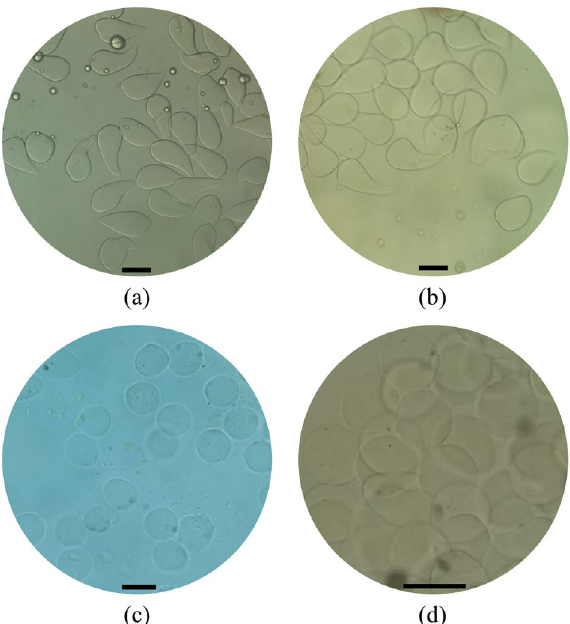
Figure 5. Alginate microgels were synthesized by using the designed microfluidic device. Calcium chloride concentration in crosslinking phase emulsion was ( a ) 4 mol/L, ( b ) 6 mol/L, ( c ) 8 mol/L, and ( d ) 10 mol/L. Scale bars are 100